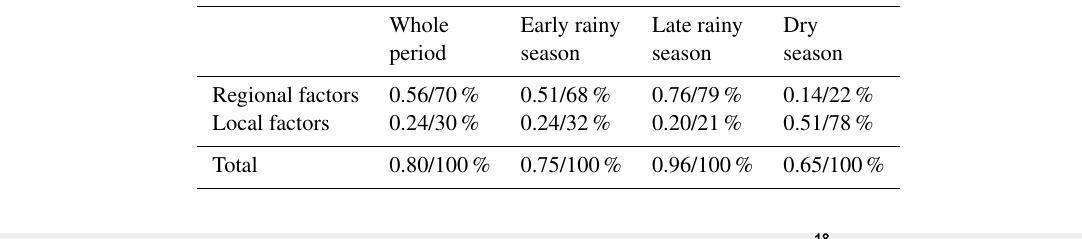
Table 4. Explained variance (partial R 2 ) in regional and local factors of the best MLR model according to the PRESS value. The first value indicates the absolute partial R 2 , the second value the relative contribution to the overall explained variance.